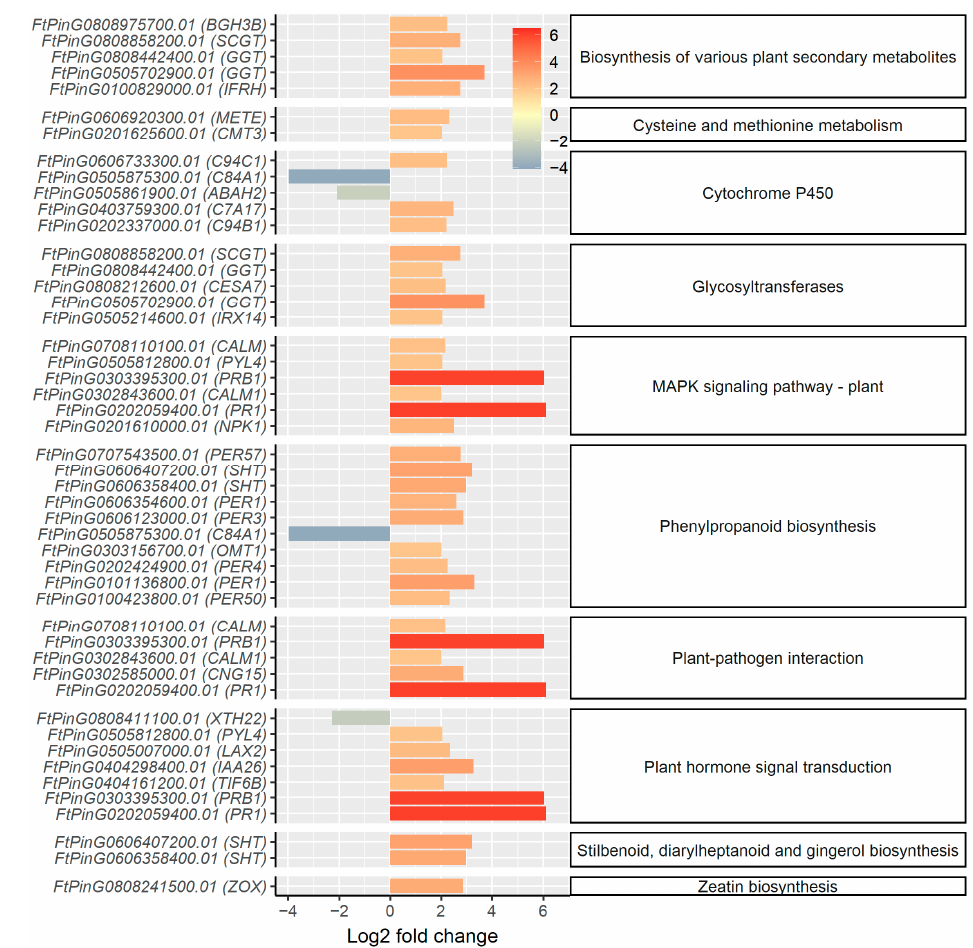
Figure 7. Fold-change of the expression levels of DEGs for the top ten KO terms with lowest p -values in the enrichment analysis. The expression level is measured as TPM of the gene. Only genes with an absolute log 2 fold-change of TPM > 2 are listed in the plot. The labels of the y axis denote the gene name, and the annotation of the gene in Swiss-Prot database is shown in brackets.